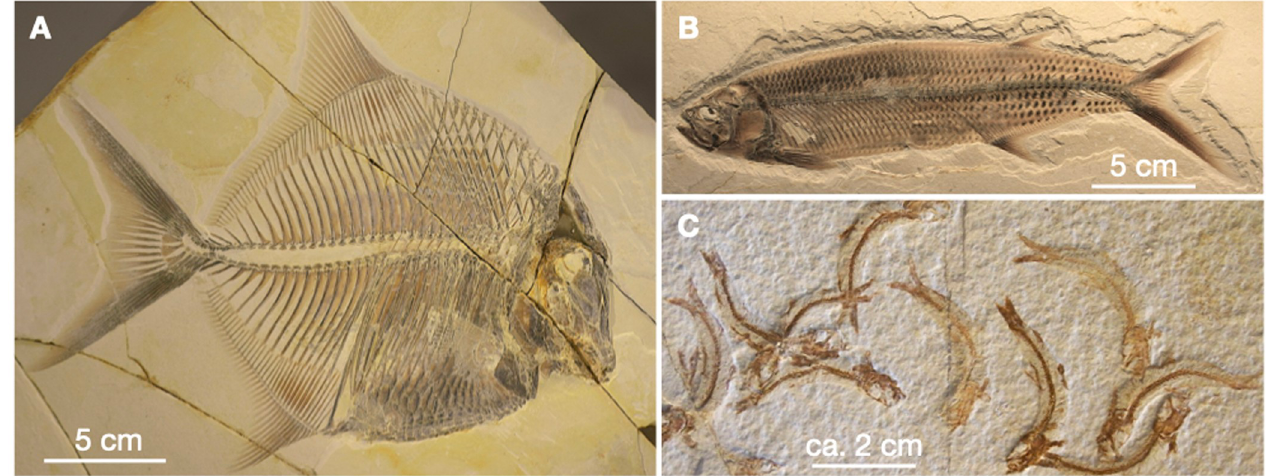
Fig 1. Fish fossils from the Solnhofen lagoons to illustrate the excellent preservation. (A)—an Upper Tithonian Pycnodontid ( Proscinetes elegans ) from the Ettling quarry (JME-ETT876), Frankonian Alb [6]. (B)— Thrissops cf . formosus from Ettling (JME-ETT74) with colour pattern preservation [5]. (C)—Species of Leptolepides sprattiformis [7] from Solnhofen (JME-SOS8059). All photos from the second author, with permission from the Jura-Museum Eichsta¨tt.